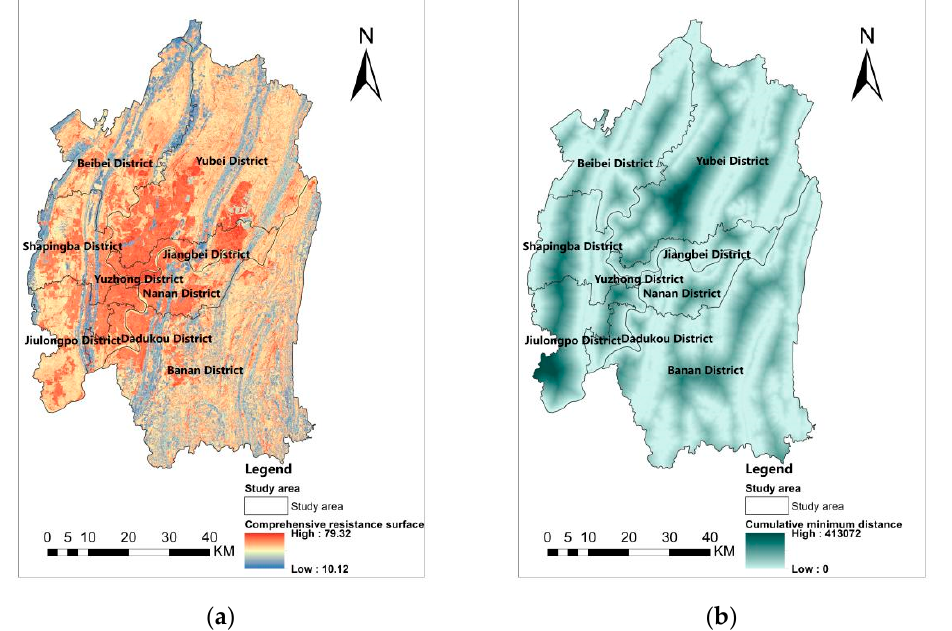
Figure 6. Comprehensive resistance surface and cumulative minimum distance ( a ) Comprehensive resistance surface ( b ) Cumulative minimum